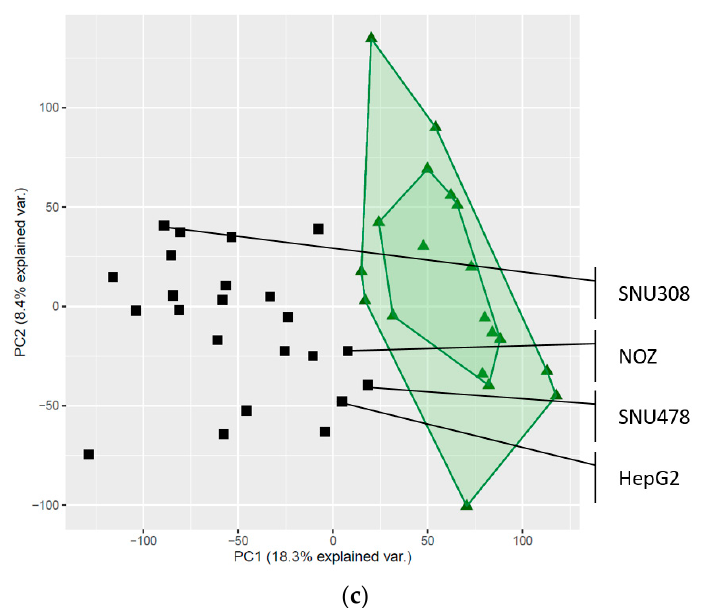
Figure 2. Principal component analysis (PCA) plots based on the combined gene expression data for the investigated cell lines and Japanese iCCA, eCCA, and GBC tumors. ( a ) PCA and bagplots with 100%, 90%, 70%, and 50% of the iCCA samples; ( b ) PCA and bagplots with 100%, 90%, 70%, and 50% of the eCCA samples; ( c ) PCA and bagplots with 100% and 60% of the GBC samples.